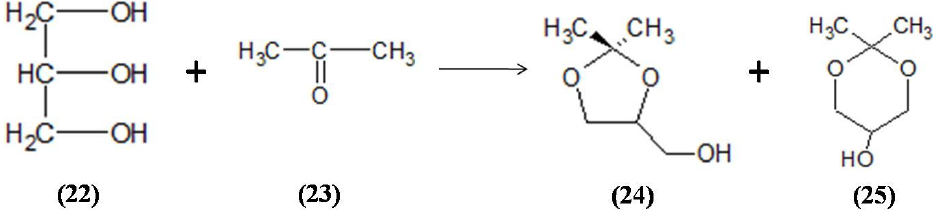
Figure 4. Main reaction products in the acetalization of glycerol (I) with acetone. Adapted from [13].